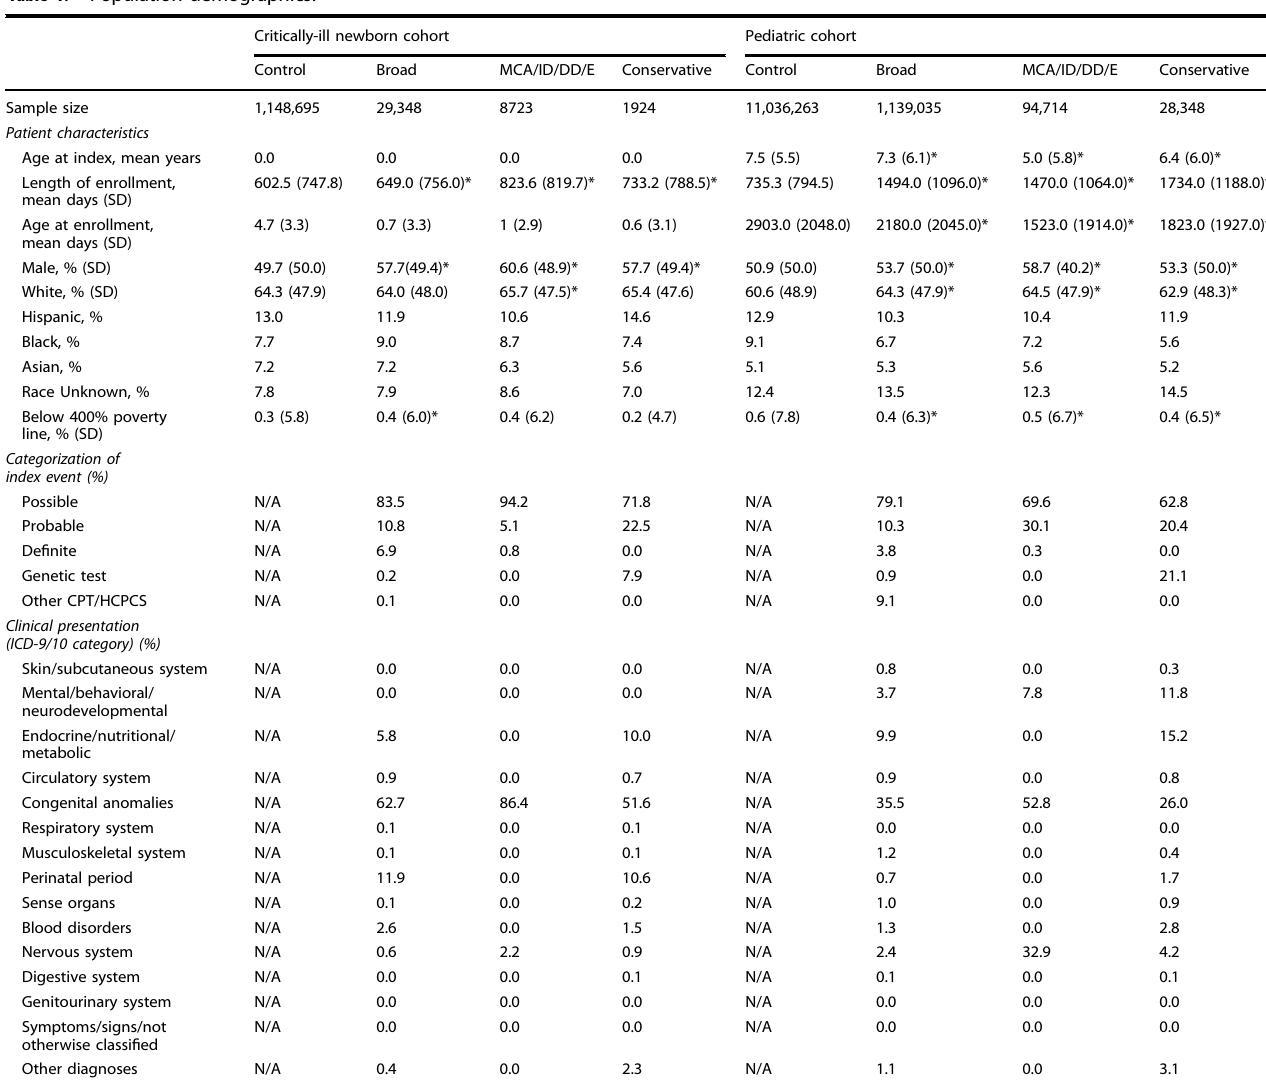
Table 1. Population